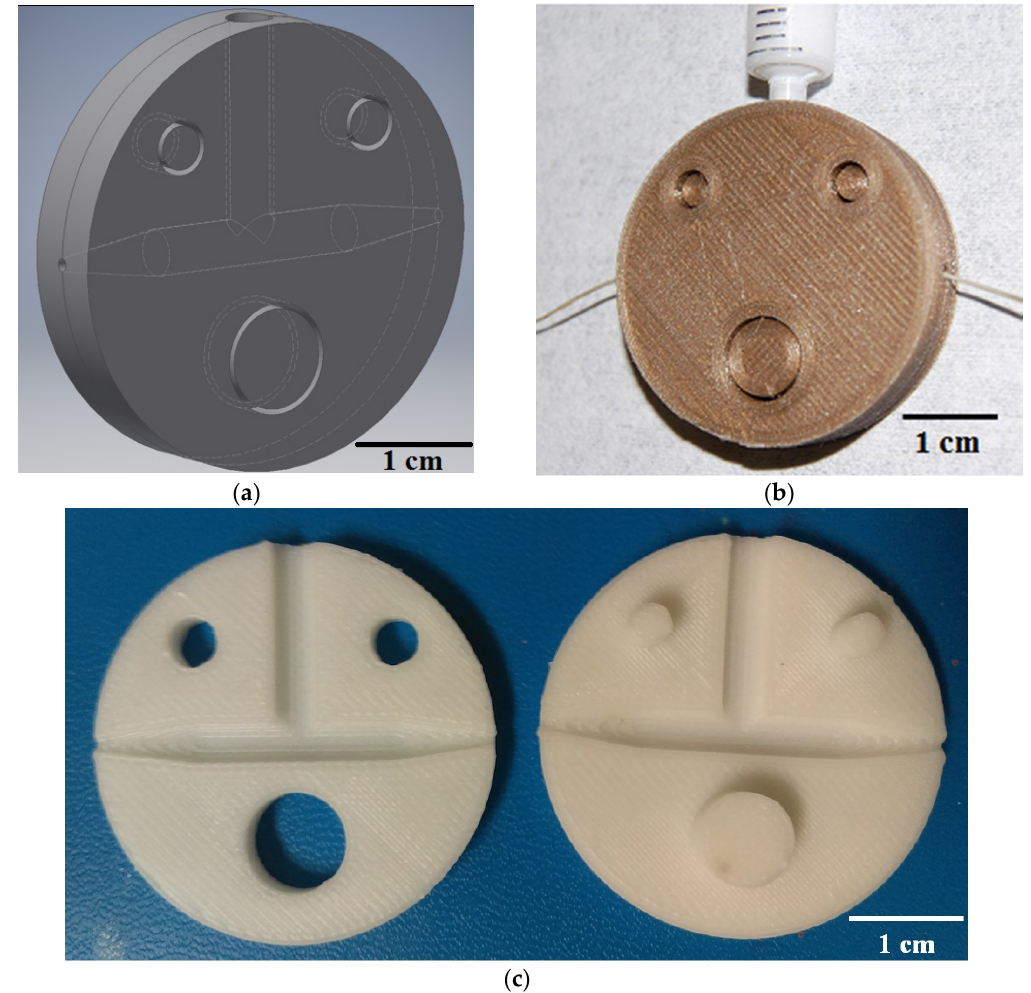
Figure 2. 3D-printed slot die coating device. ( a ) Autodesk Inventor ® CAD screen capture of the device model; ( b ) Photograph of fiber coating method using device printed with polylactic acid (PLA); ( c ) Photograph of physical device printed with acrylonitrile butadiene styrene (ABS)